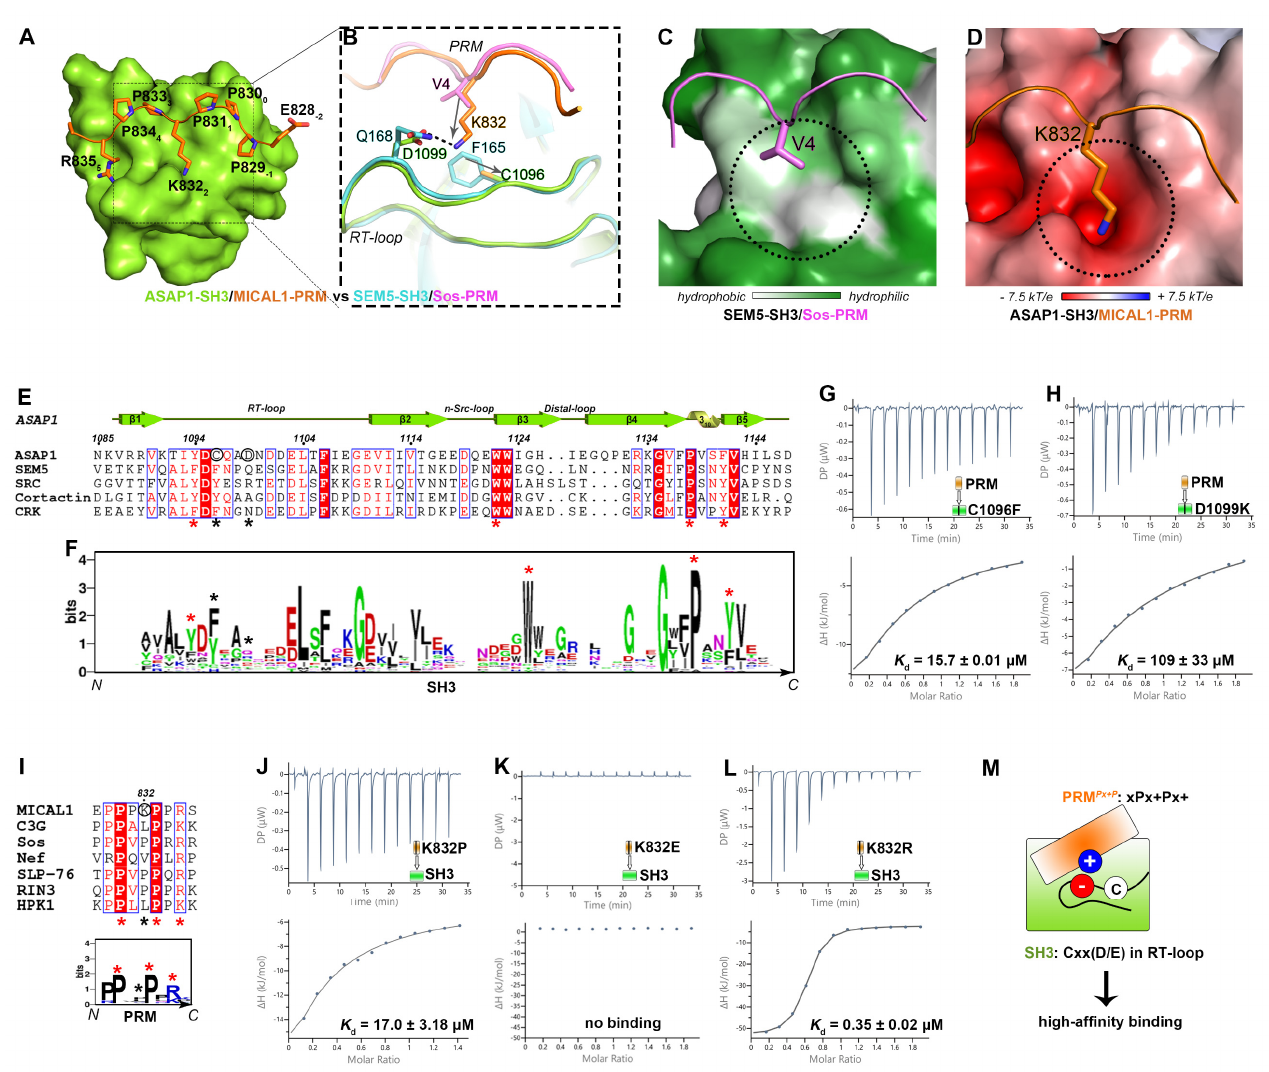
Figure 2. A Cxx(D/E) sequence in the RT-loop of ASAP1-SH3 determines the high-affinity binding to the PRM Px+P in MICAL1. ( A ) Complex structure of ASAP1-SH3 (green in surface mode) and MICAL1-PRM (orange in stick mode). The subscript number ( − 2 to 5) indicates the position of each residue in MICAL1-PRM. ( B ) Structural comparison showing the major interface difference between ASAP1-SH3/MICAL1-PRM and SEM5-SH3/Sos-PRM (PDB ID: 1SEM) complexes. The salt bridge is indicated by the black dash line. The length change of the sidechain of the residues in the corresponding position is indicated by gray arrows, respectively. ( C , D ) Surface analyses showing the hydrophobic pocket in SEM5-SH3 ( C ) and the negatively charged pocket in ASAP1-SH3 ( D ), respectively. ( E , F ) Sequence alignment ( E ) and Weblogo-style representation ( F ) of the SH3 domain sequences. The Weblogo-style representation was generated from the sequence analysis of >100 human SH3 domains. The conserved four aromatic residues in the hydrophobic groove of SH3 domains are labeled with red asterisks. The unique residues C1096 and D1099 in ASAP1 are circled and their corresponding positions are labeled with black asterisks. ( G , H ) ITC-based affinity measurements of MICAL1-PRM binding to the ASAP1-SH3 mutations. ( I ) Sequence alignment and Weblogo-style representation of the class-II PRMs. The conserved residues are labeled by red asterisks. The unique residue K832 in MICAL1 is circled and its corresponding position is labeled by a black asterisk. ( J – L ) ITC-based affinity measurements of MICAL1-PRM with the mutations of K832 binding to ASAP1-SH3. ( M ) A cartoon model summarizing the high-affinity binding between the SH3 with a unique Cxx(D/E) sequence in RT-loop and the PRM Px+P